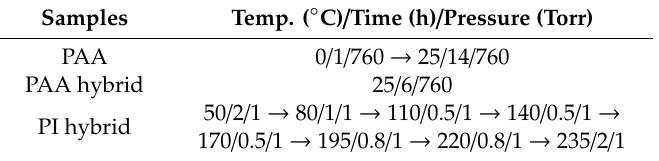
Table 1. Heat treatment conditions of PI hybrid films.